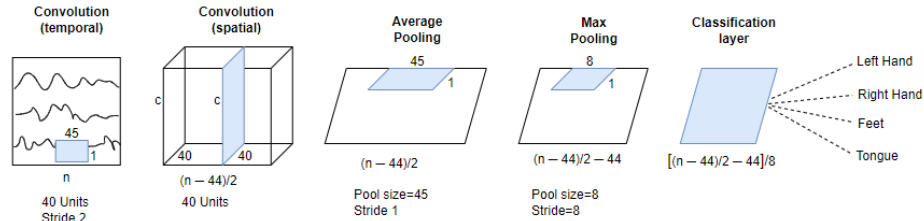
Figure 2. Shallow Convolutional Neural Network as baseline architecture.